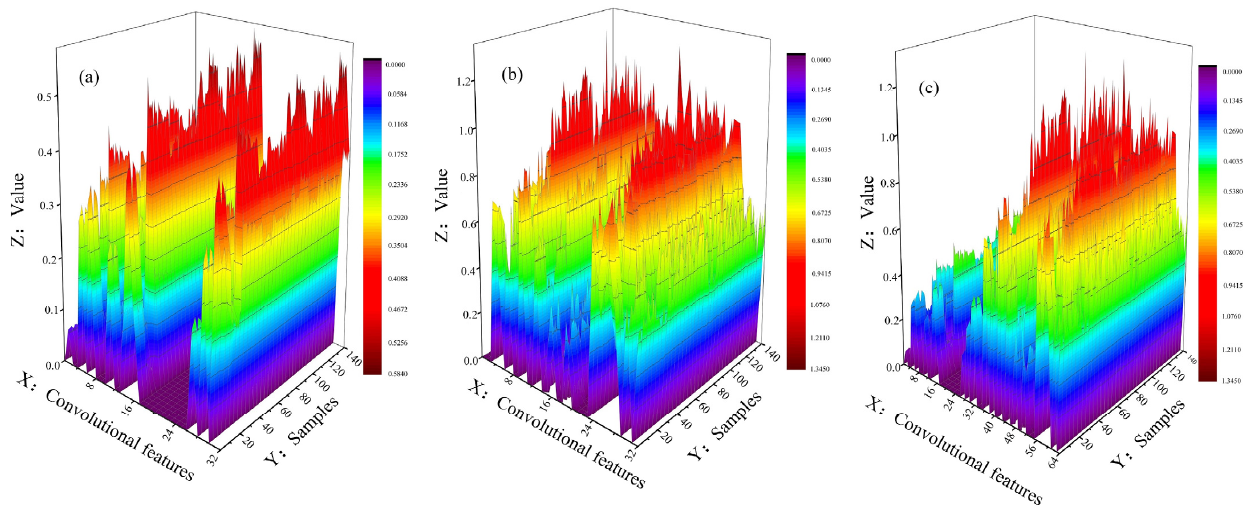
Figure 8. Heat map of deep features, including ( a ) spectral deep features, ( b ) spatial deep features, and ( c ) spectral-spatial deep features.